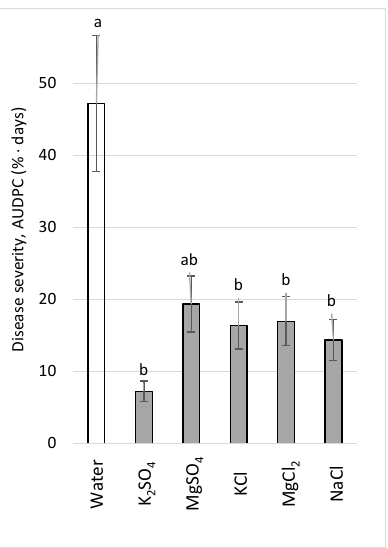
Figure 9. Effect of Cl- and SO 4 -containing salts on cucumber downy mildew (CDM, Pseudoperonospora cubensis ) after spraying 0.2 M solutions every 14 days, calculated according to the anion. CDM severity was evaluated on a 0 to 100% scale, where 0% = no disease symptoms and 100% = leaf fully covered by CDM symptoms; the area under the disease progress curve (AUDPC) was calculated. Values followed by a common letter are significantly not different from each other according to Tukey-Kramer’s HSD test ( p ≤ 0.05).